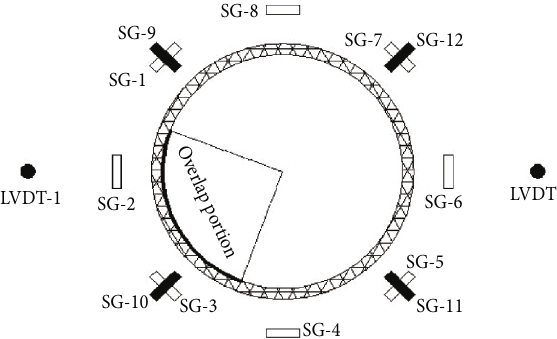
Figure 7: The position of strain gauge and displacement